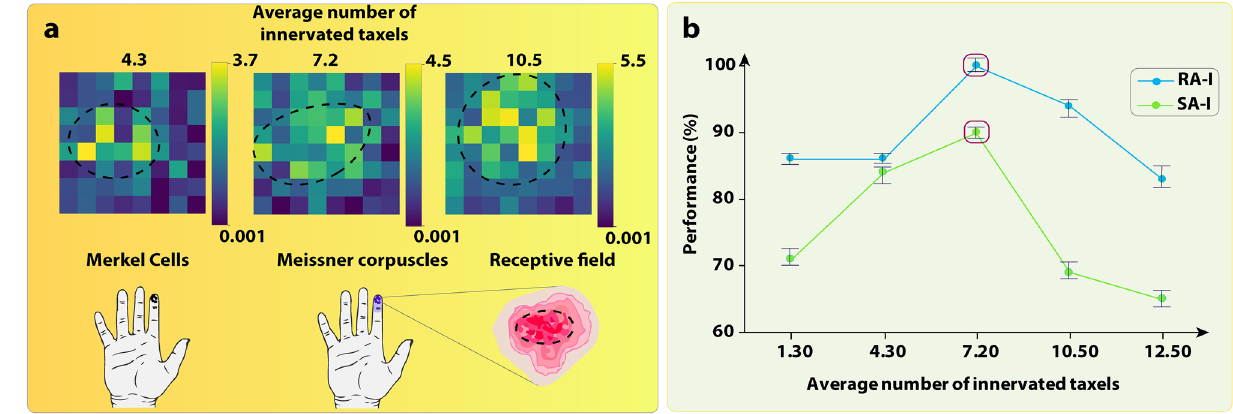
Figure 3. The effect of innervation on the robotic data classification. ( a )-up, The three innervation samples of the receptive field for both SA-I and RA-I afferents with the different average number of innervated taxels by one afferent. The black dashed circles illustrate highly sensitive zones. The heatmap illustration was used to demonstrate the weight of each taxel. ( a )-down, The receptive field of two classes of mechanoreceptors, Merkel and Meissner in which Meissner’s receptive fields are shown. ( b ) Classification performance of SA-I and RA-I afferents for texture recognition (S1 to S6) when the receptive field size is changed. The Firing rate algorithm was used right after the sensor started to scan the